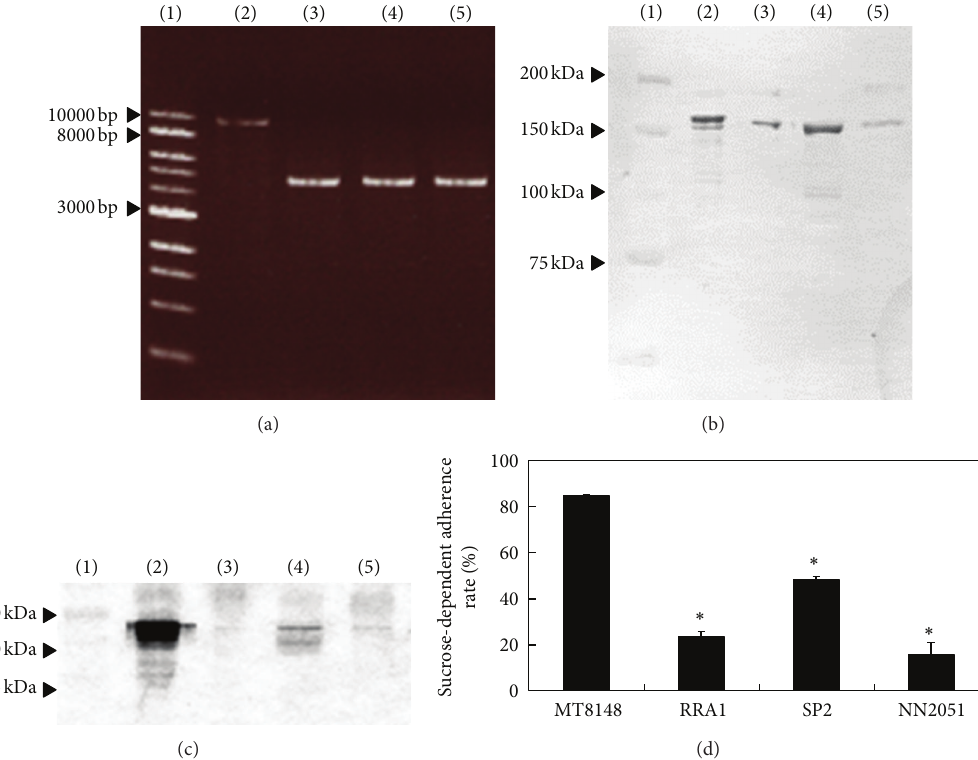
Figure 2: PCR amplification of gtfB and gtfC regions (a), western blot analysis (b), activity staining (c), and sucrose-dependent adherence (d) of MT8148, RRA1, and 2 clinical strains. Lane 1: molecular marker, Lane 2; MT8148, Lane 3; RRA1, Lane 4; SP2, Lane 5; NN2051. There were significant differences between MT8148 and the other strains ( ∗ 𝑃 < 0.001 ).